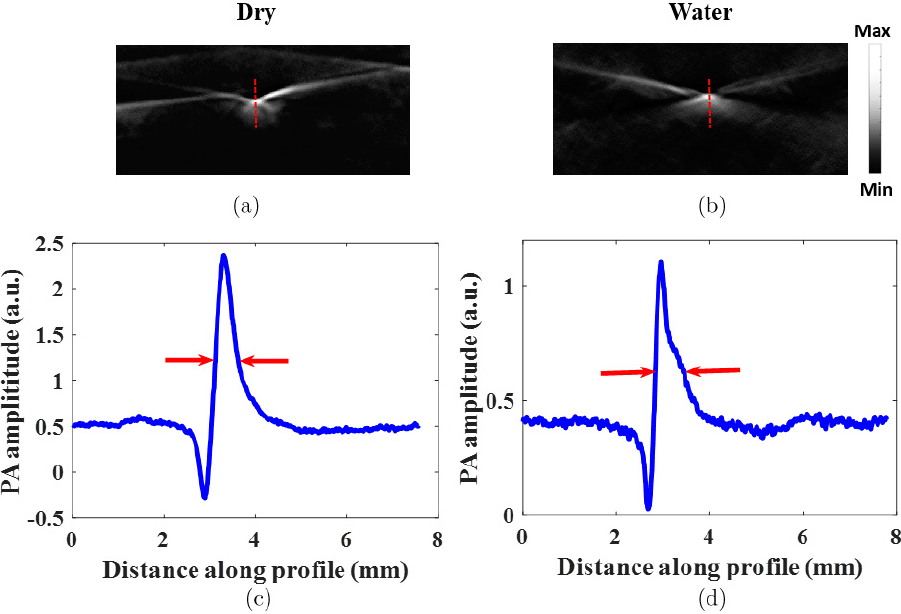
Fig. 2. Spatial resolution quanti¯cation of the PAT system. PAT image with dry coupling (a) and water coupling (b). (c) Photoacoustic image pro¯le along the red dashed line in (a). (d) Photoacoustic image pro¯le along the red dashed line in (b).